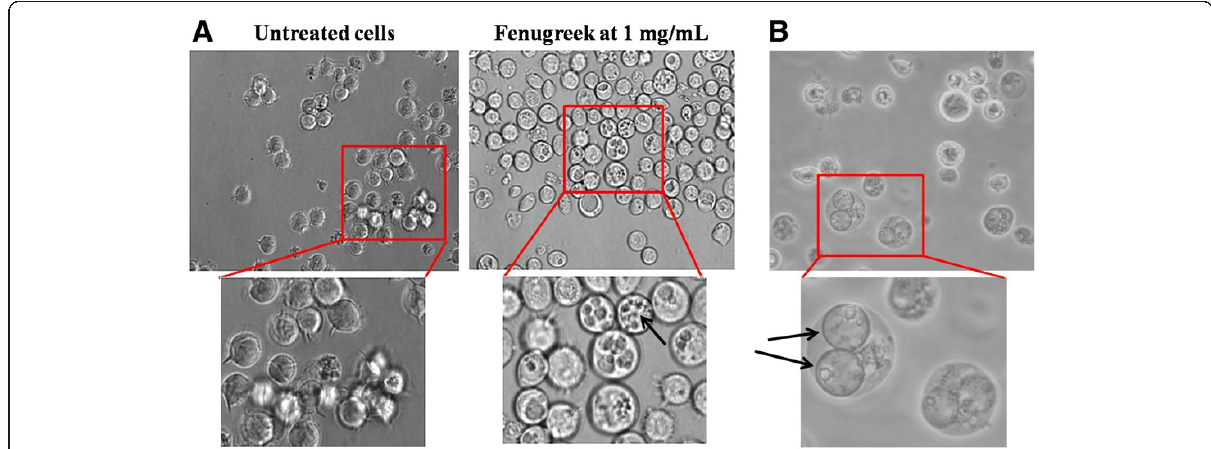
Figure 3 Fenugreek extract induced vacuoles in Jurkat cells. Overnight incubation of Jurkat cells with 1 mg/mL of fenugreek extract induced distinct vacuoles. ( A ) The number of vacuoles range from 1 to several per cell. Arrow points to multiple vacuoles in a cell. ( B ) Arrows point to Jurkat cells possessing two large spherical vacuoles. Pictures represent inverted light microscopic images taken at 400x